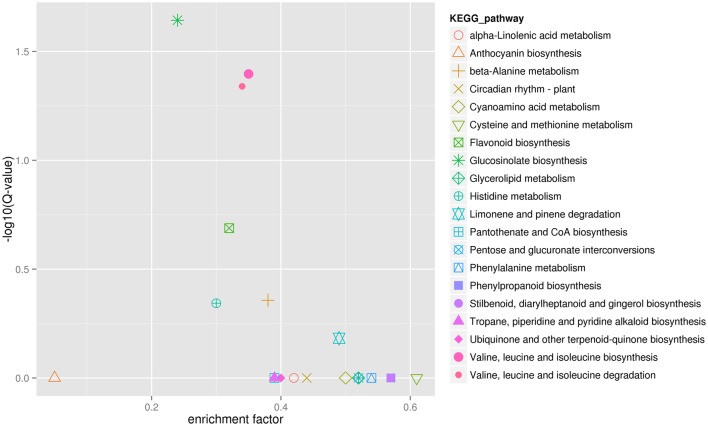
KEGG enrichment of differentially expressed genes in JL-08 and JL-09 sprouts. The X axis is the enrichment factor of different KEGG pathway. The Y axis represented different Q-value of different KEGG pathway. The different symbols represented for different KEGG pathway.